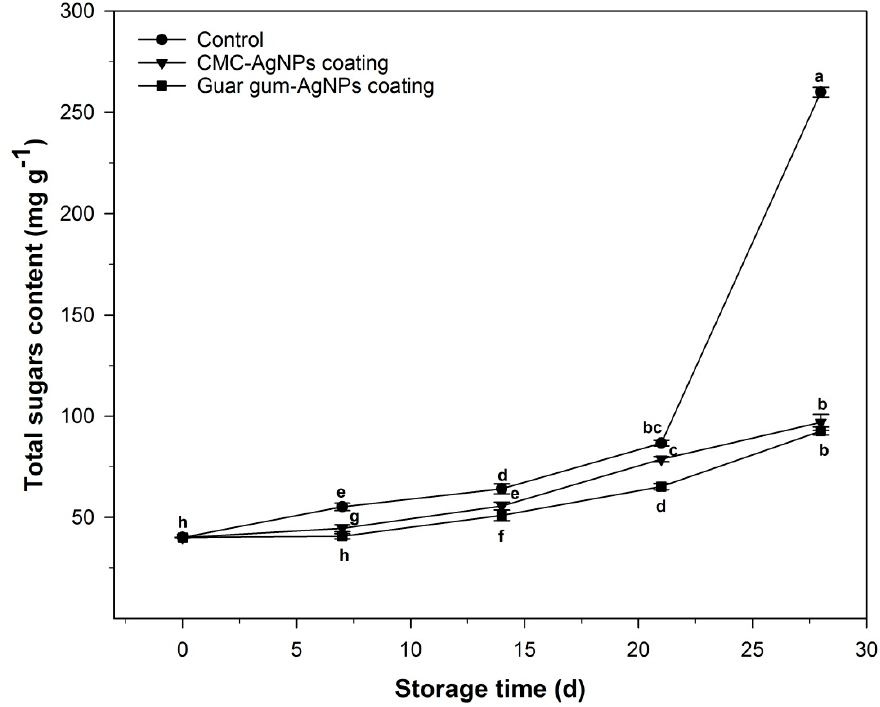
Figure 11. Effect of CMC-AgNP and guar gum-AgNP coatings on total sugar content of “Seddik” mango fruit stored at 13 °C for 4 weeks. Vertical bars represent the SE of means. Means with the same letter are not significantly different according to Duncan’s multiple range test ( α ≤ 0.05).